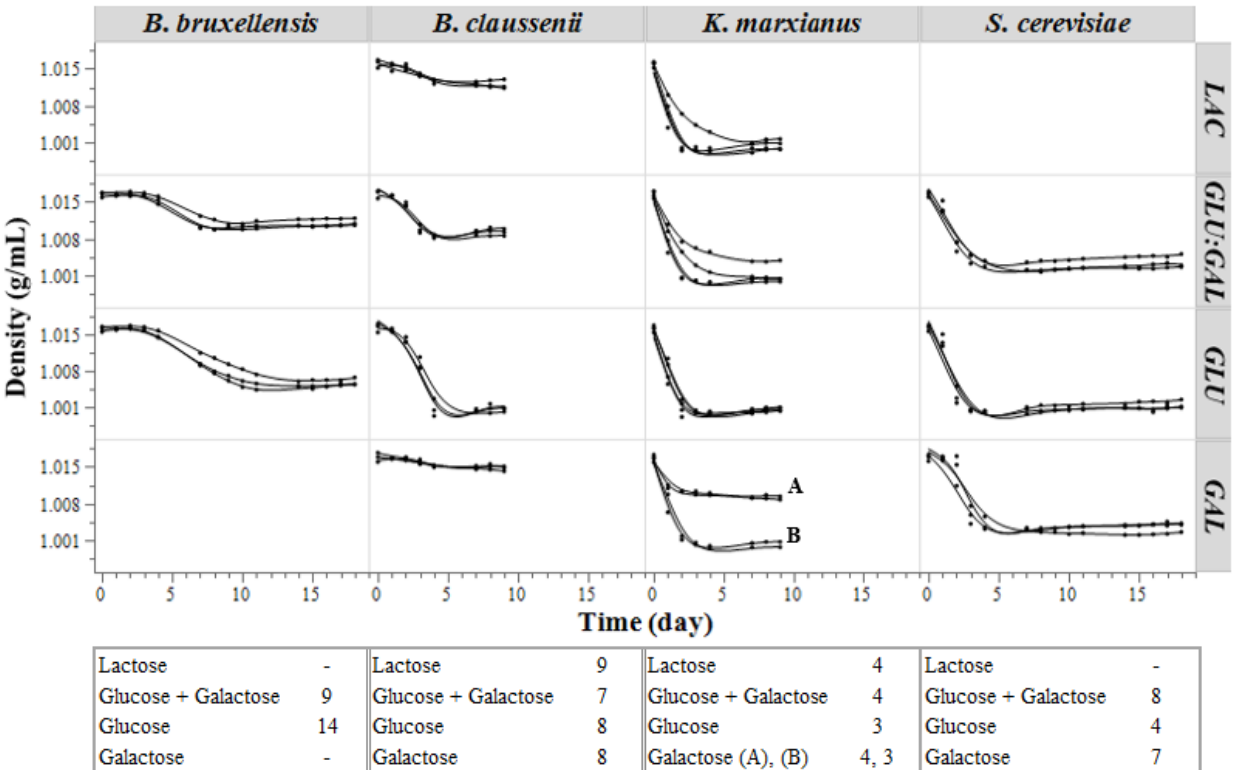
Figure 1. Density measurements of fermentates containing sugars associated with acid whey; fermentates were held at 25 °C and subjected to shaking at 185 rpm. Investigated sugars, supplemented at an initial concentration of 40 g/L: glucose (GLU); galactose (GAL); 1:1 ratio of glucose and galactose (GLU:GAL); and lactose (LAC). Three biological replicates are presented for each treatment, with the exception of those involving K. marxianus , for which a fourth biological replicate was executed and presented. Below the graph is a table which indicates the number of days necessary for each fermentation to reach a stable density, which has been defined as the end of the fermentation. Three treatments ( B. bruxellensis /LAC; B. bruxellensis /GAL; S. cerevisiae /LAC) have been excluded here and in all subsequent figures and tables, as those treatments consistently showed signs of contamination. The results of K. marxianus in GAL have been subcategorized into treatments GAL(A) and GAL(B), based on the different trends observed in this substrate.